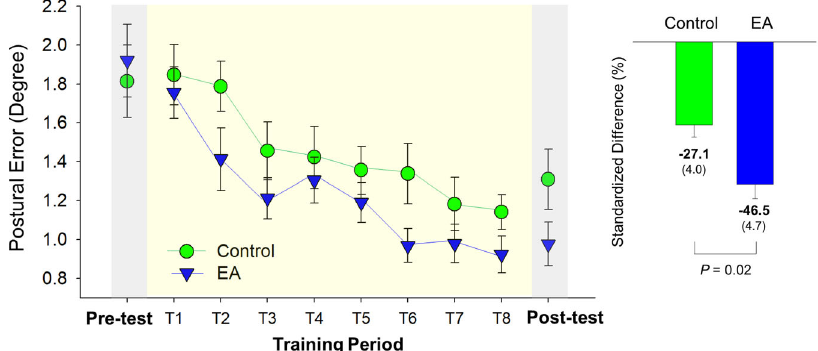
Fig. 1 Changes in task errors for the stabilometer task during the practice session for the error ampli fi cation (EA) and control groups, in reference to the task errors in the pre-test and post-test. The standardized differences in task errors (or performance bene fi ts) were contrasted between the two groups, in support of a greater amount of balance improvement due to the use of EA feedback. (The error bars on the bar charts represent standard error.).